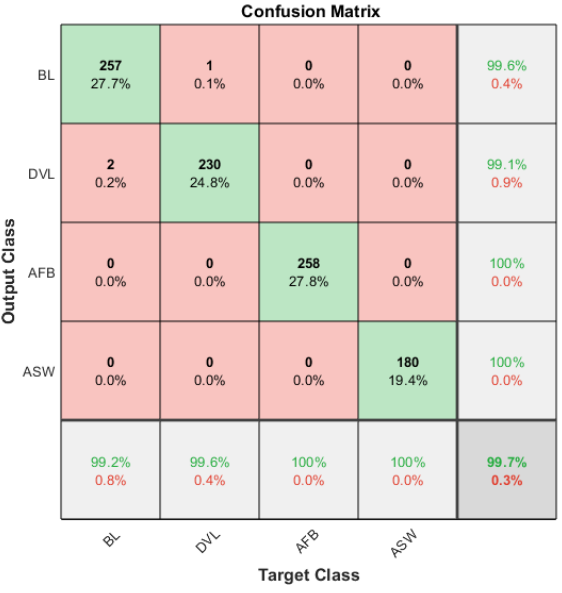
Figure 9. Confusion matrix of the testing accuracy.